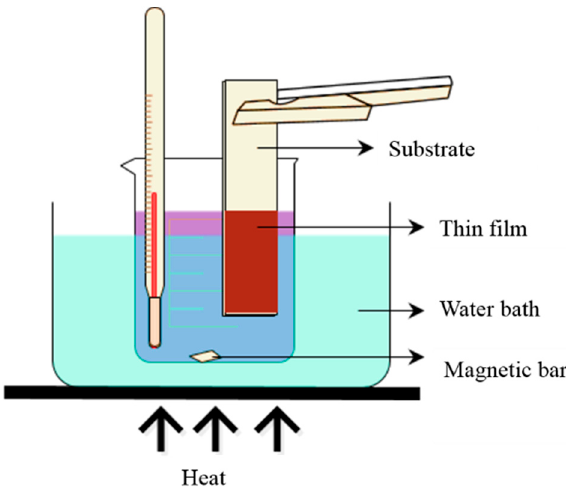
Figure 12. The schematic illustration of the chemical bath deposition (CBD) method.